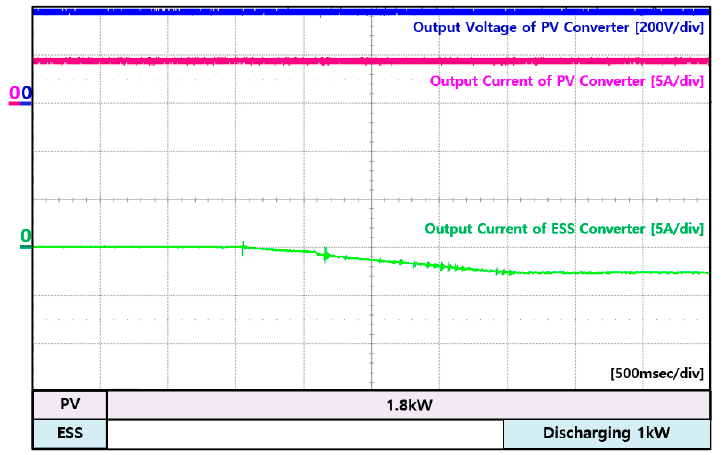
Figure 38. Experiment waveforms of PV converter and ESS converter in mode 8.